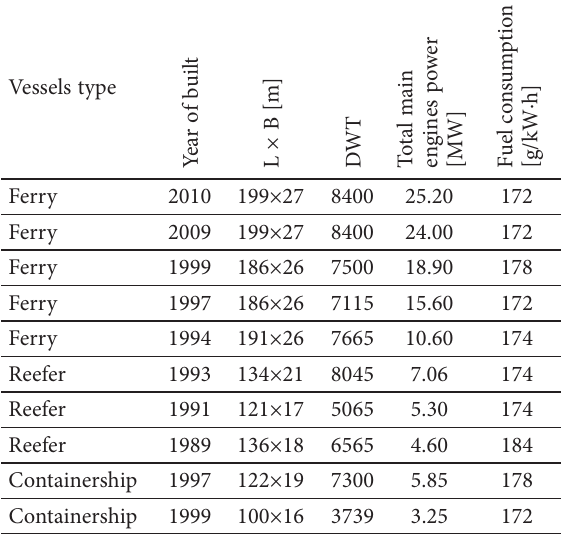
Table 4. The parameters of the selected vessels